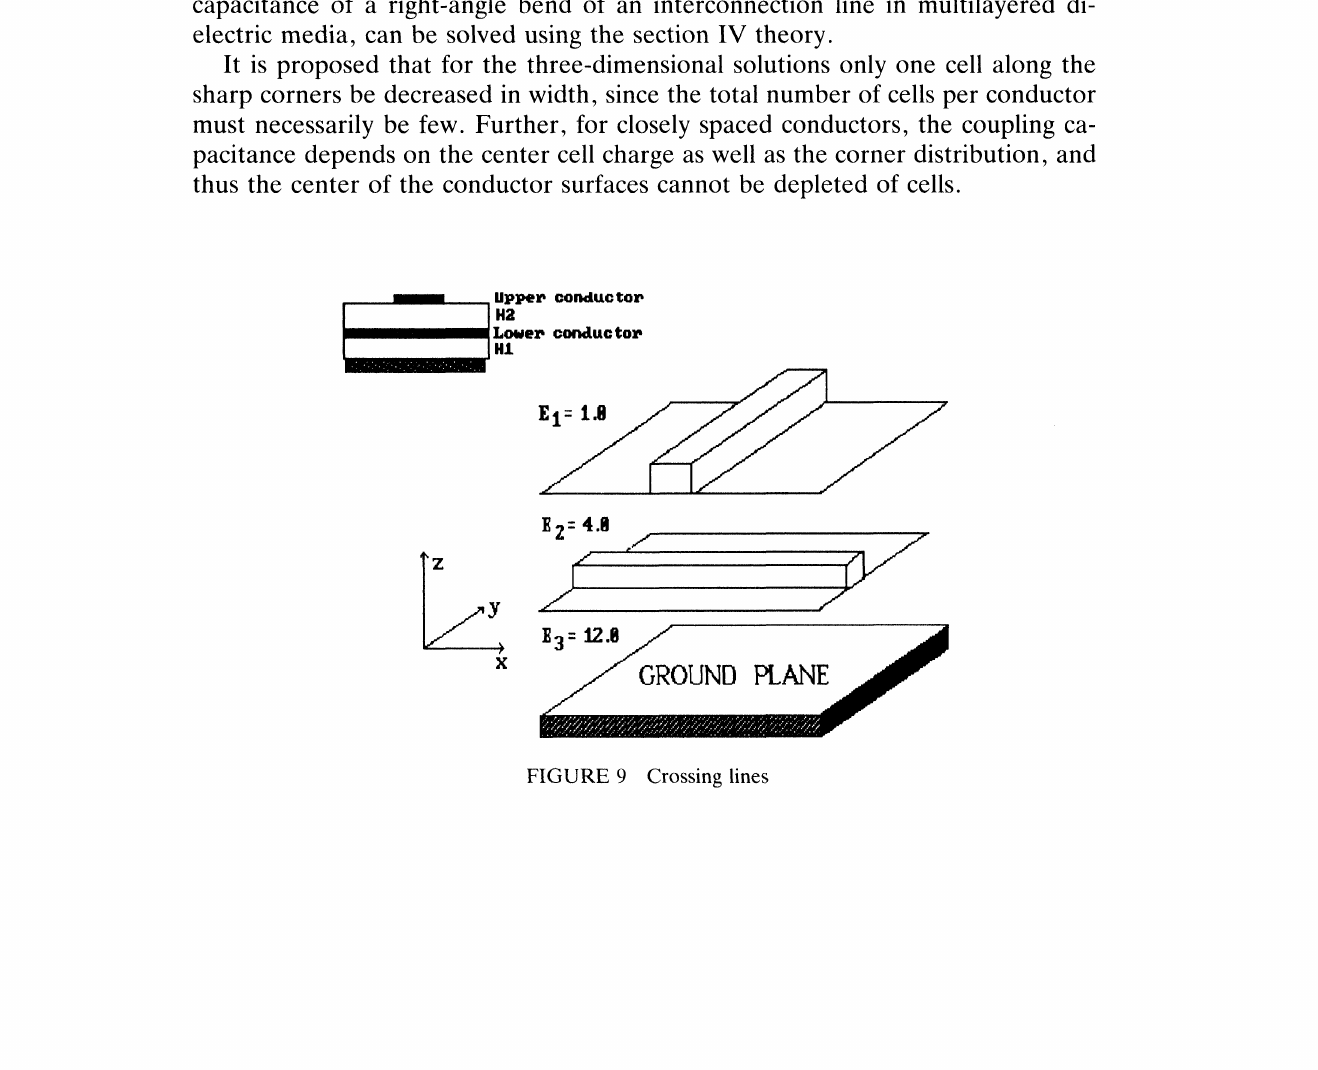
FIGURE 9 Crossing